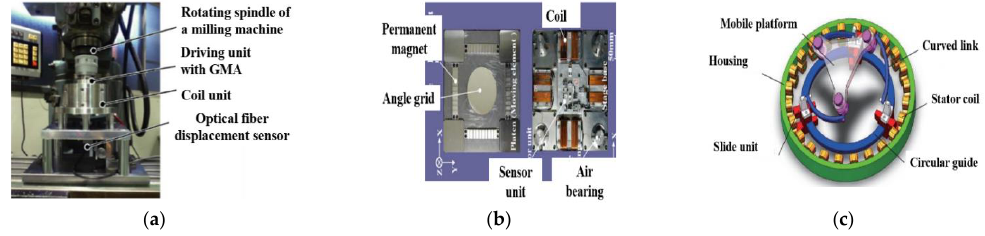
Figure 9. ( a ) Rotary linear precision motion platform [94]; ( b ) XY plane motion platform. Reprinted with permission from ref. [95] Copyright 2004 Elsevier; ( c ) a conceptual design of SMG. Reprinted with permission from ref. [97] Copyright 2018 Elsevier.